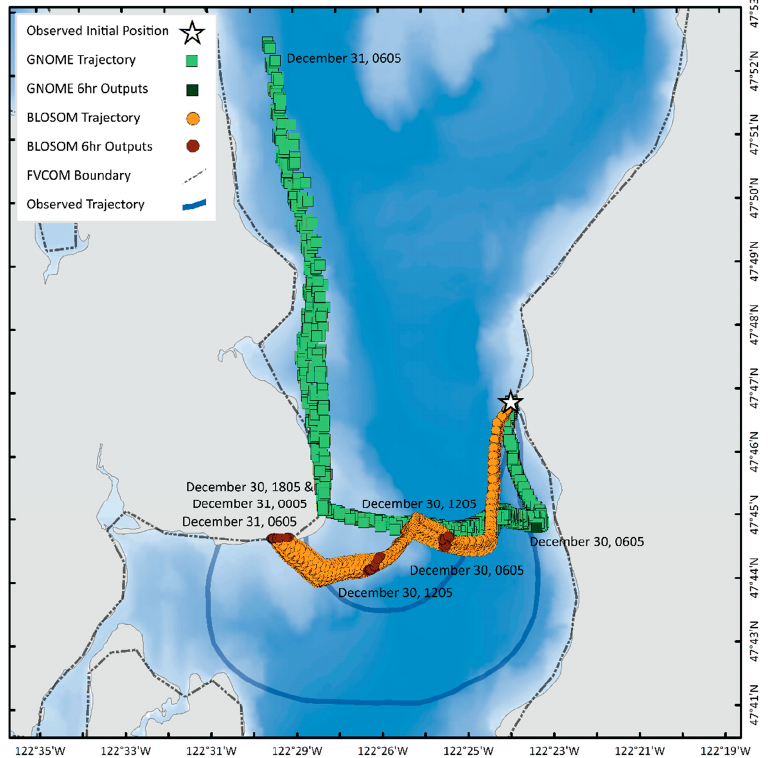
Figure A2. Same as plot A1 but both models using a 6 min time step.